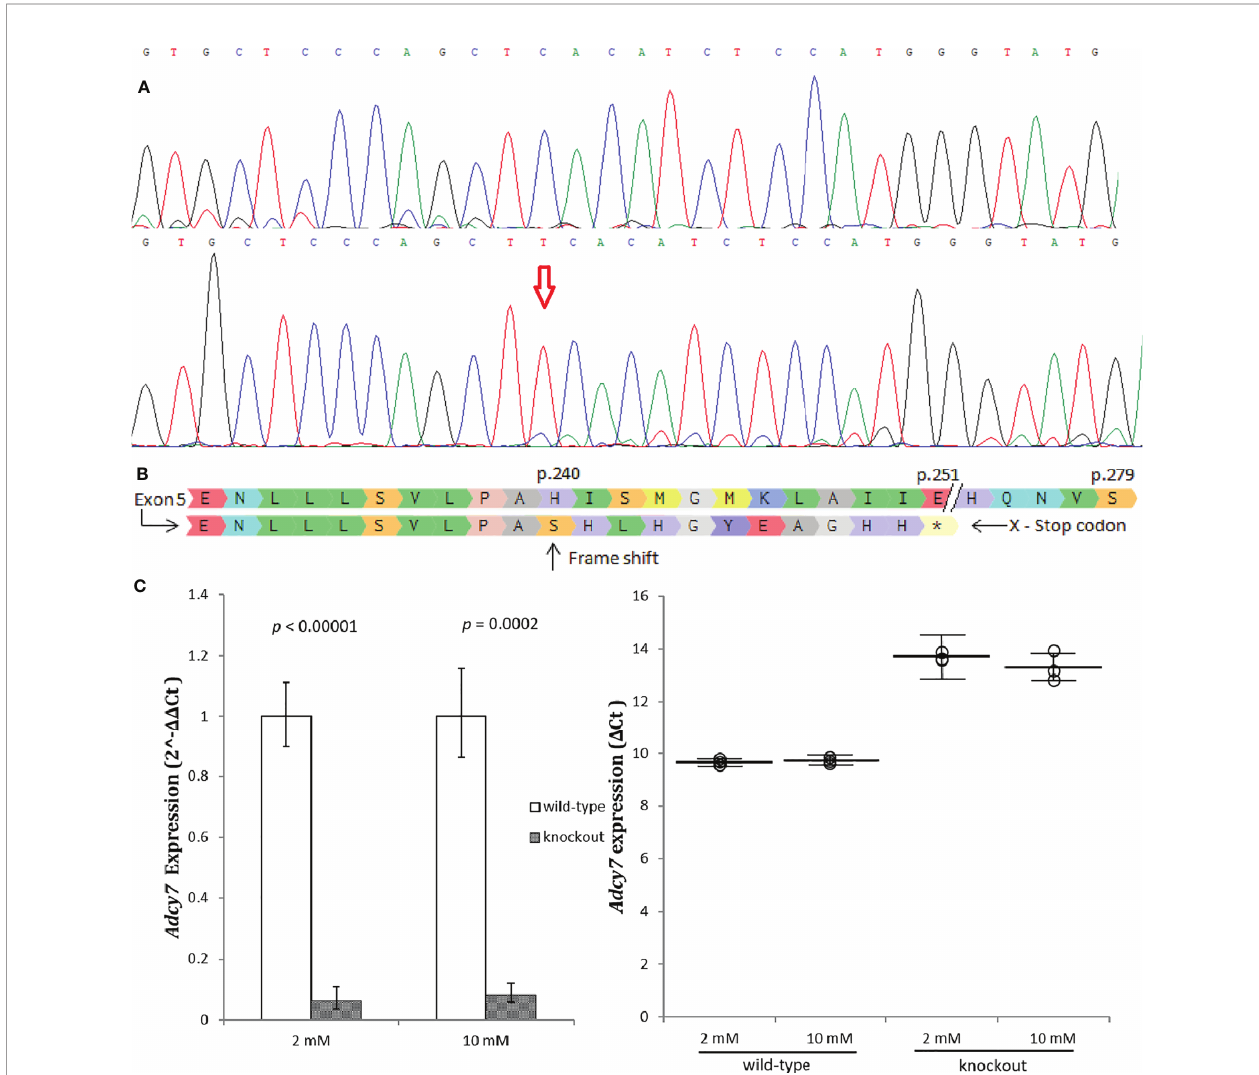
FIGURE 2 | Adcy7 knockout establishment. (A) Sanger sequencing wild-type RIN-m ( Adcy7 / Adcy7 ) (Top) compared to the mutant cell line (bottom) con fi rmed an insertion creating a frameshift. (B) Amino acid sequencing with a reference (top) shows indel creating a frameshift causing a premature termination codon located in 11 codons downstream. (C) Adcy7 mRNA levels established by quantitative RT-PCR indicating a very low expression level. The CT values were normalized to b - actin to yield D CT and 2^- DD CT values presented in dots and bar chart, respectively. Each dot represents an individual sample, whereas the horizontal lines represent the mean and standard error of the mean. D CT values were then calculated and presented as 2^- DD CT values (fold change) in a bar chart. Unpaired t-test with delta CT and SE ± values were used for statistic